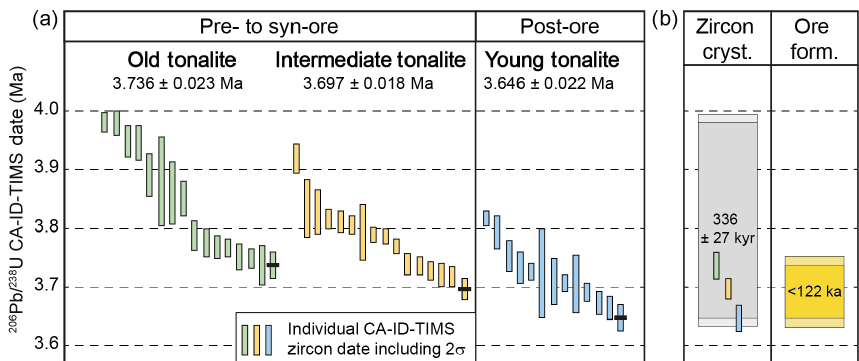
Figure 5. High-precision U–Pb CA–ID–TIMS zircon dates from the three tonalite porphyries. Vertical bars are individual analyses including analytical uncertainty (2 σ ). The youngest crystallisation age is used as the best approximation for porphyry emplacement. The extended range in zircon crystallisation ages in each sample indicates protracted crystallisation. The yellow box indicates maximum duration of ore formation as constrained by the emplacement age of the old tonalite and the young tonalite. The grey box illustrates the duration of zircon crystallisation recorded by CA–ID–TIMS geochronology. The vertical bars in the grey box are emplacement ages of the tonalites, demonstrating > 200kyr of zircon crystallisation before emplacement of the first porphyry intrusion and start of Cu–Au